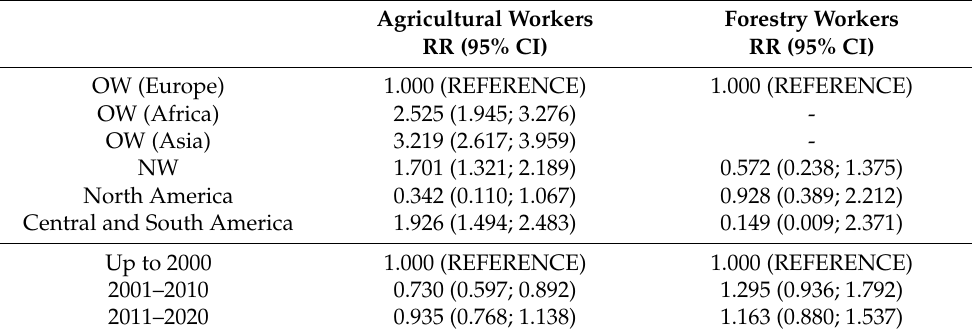
Table 3. Comparison of the seropositive status in agricultural workers and forestry workers by geographic origin. Notes: RR = rate ratio; 95% CI = 95% confidence intervals; OW = Old World (i.e., Eurasia and Africa); NW = New World (i.e., North and Central/South America).